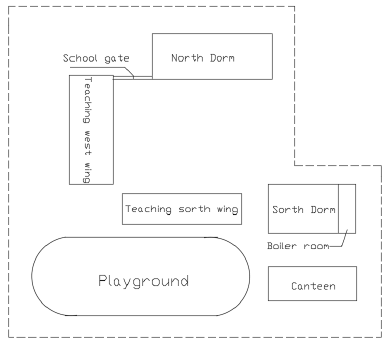
Figure 2. Regional layout of the school.